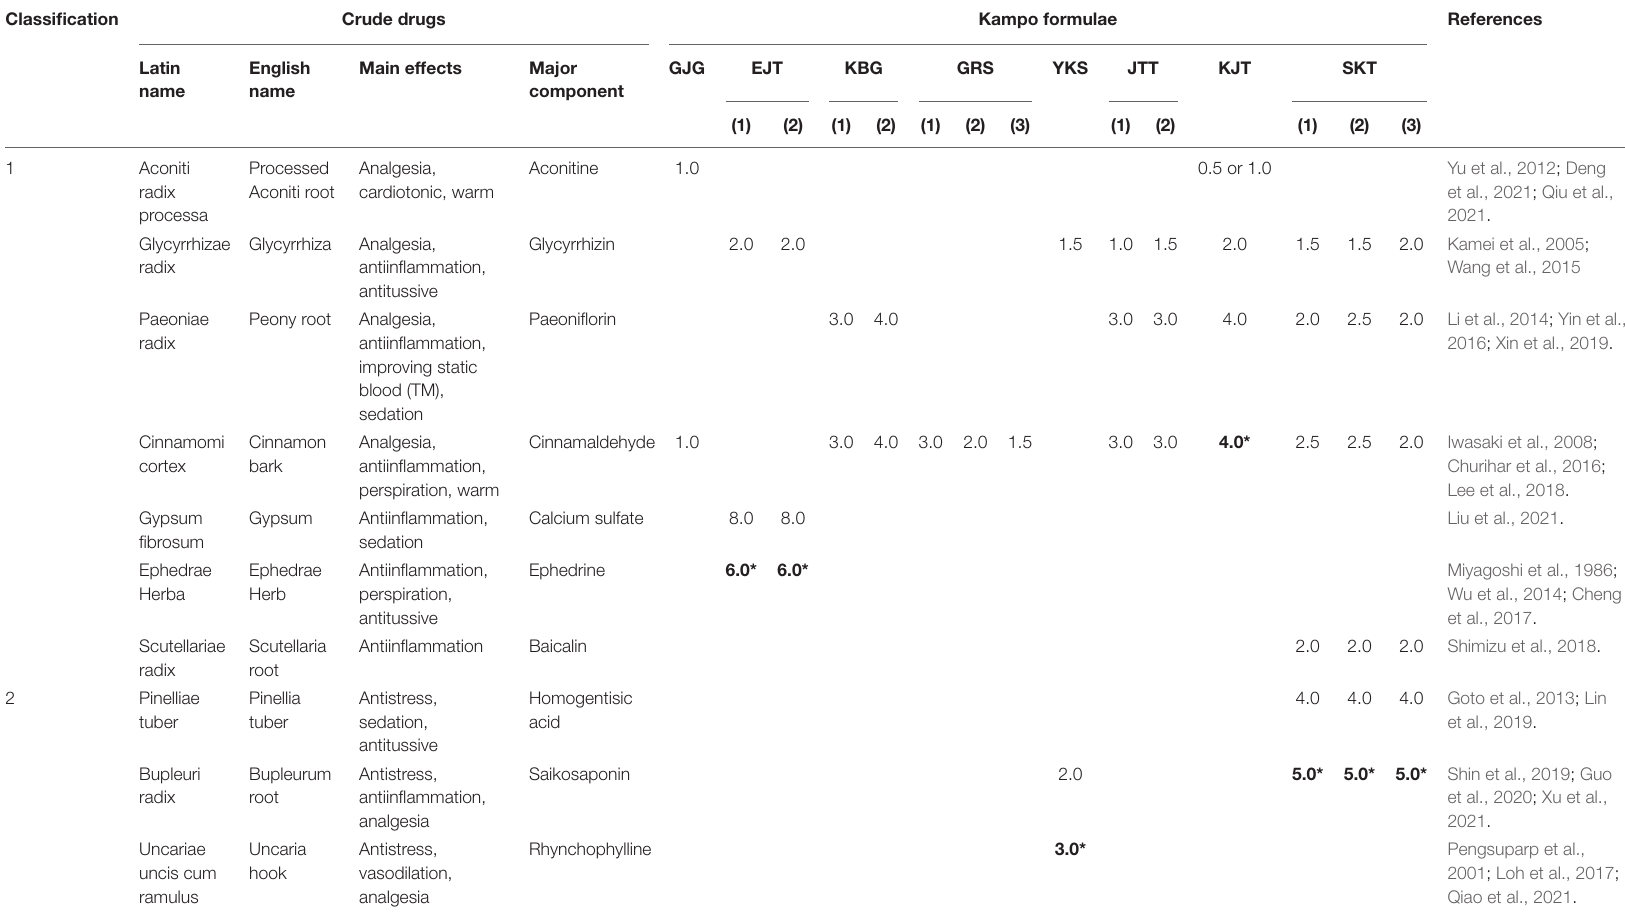
TABLE 2 | Kampo formulae for chronic pain and crude constituent drugs.